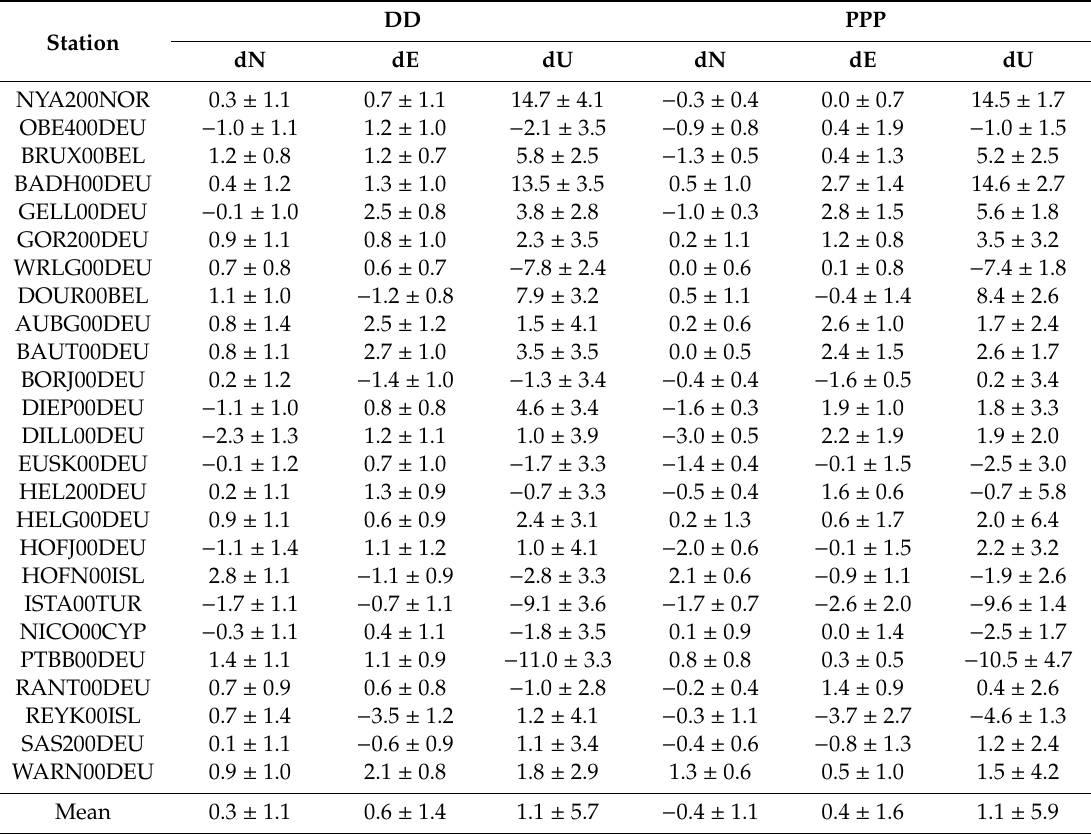
Table A6. Coordinate di ff erences between solution G1 and G2 (G2 minus G1) and their standard deviations. All values in